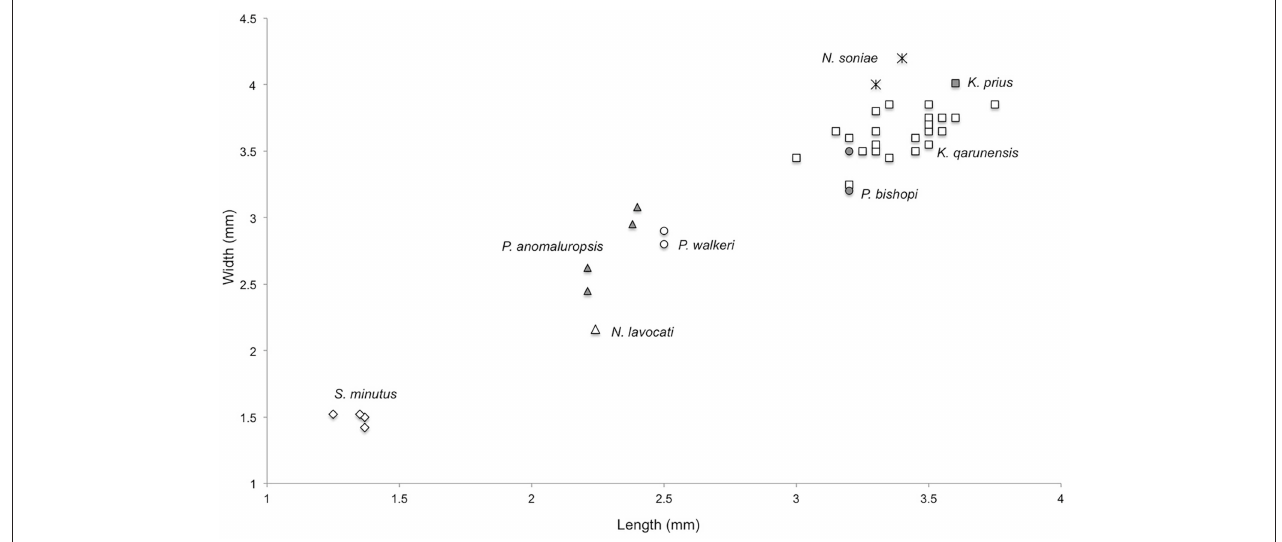
FIGURE 5 | Bivariate plot of length vs. width of M 2 among various fossil and extant anomaluroids. Symbols are as follows: Shazurus minutus , open diamonds; Pondaungimys anomaluropsis , closed triangles; Nementchamys lavocati , open triangle; Paranomalurus walkeri , open circles; Paranomalurus bishopi , closed circles; Nonanomalurus soniae , asterisks; Kabirmys qarunensis, open squares; Kabirmys prius , closed